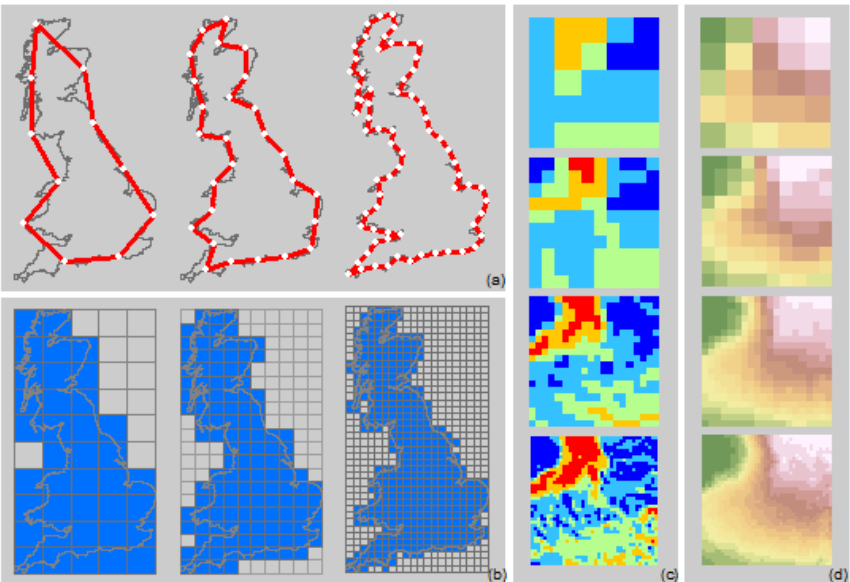
Figure 2. (Color online) Illustration of how measurement changes with scales. Note: The length of the coastline changes with yardsticks ( a ); the area of the island and the slope of the surface change with boxes and digital elevation model (DEM) resolutions ( b,c ); the five slope classes between blue and red are respectively, 0–6.8, 6.8–12.4, 12.4–18.7, 18.7–26.9, and 26.9–40.9 degrees. Derived for the same area but with different resolutions of DEMs ( d ), the slopes look very different with different resolutions, such as more areas of high slopes in higher-resolution DEMs.